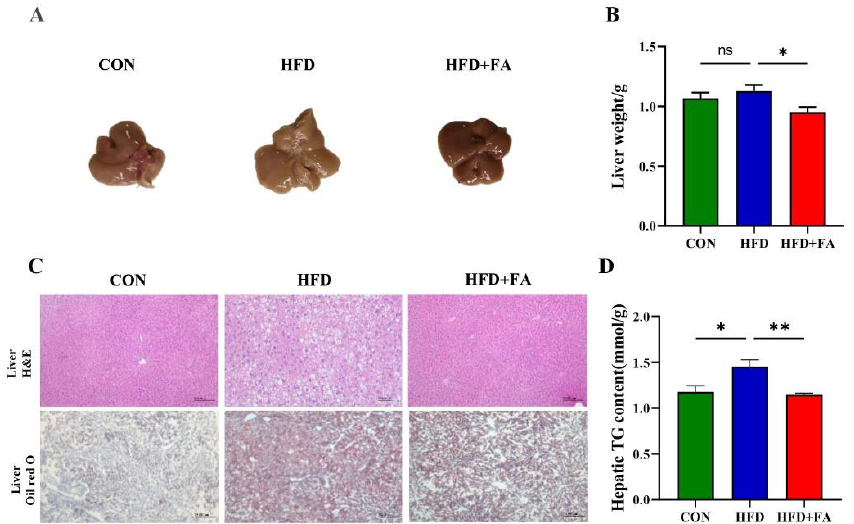
Figure 1. Ferulic acid (FA) reduces hepatic steatosis. ( A ) Representative images of the livers of mice from the three groups CON, HFD, and HFD+FA. ( B ) Liver weight (g) of the mice from the three groups CON, HFD, and HFD+FA ( n = 10). ( C ) Representative images of (H&E)-stained and Oil Red O-stained liver sections of mice from the three groups, CON, HFD, and HFD+FA at endpoint (12 weeks). Scale bars, 50 µm. ( D ) Liver TG level of mice from the three groups, CON, HFD, and HFD+FA ( n = 10). Data are shown as mean ± SEM. * p < 0.05, ** p < 0.01.